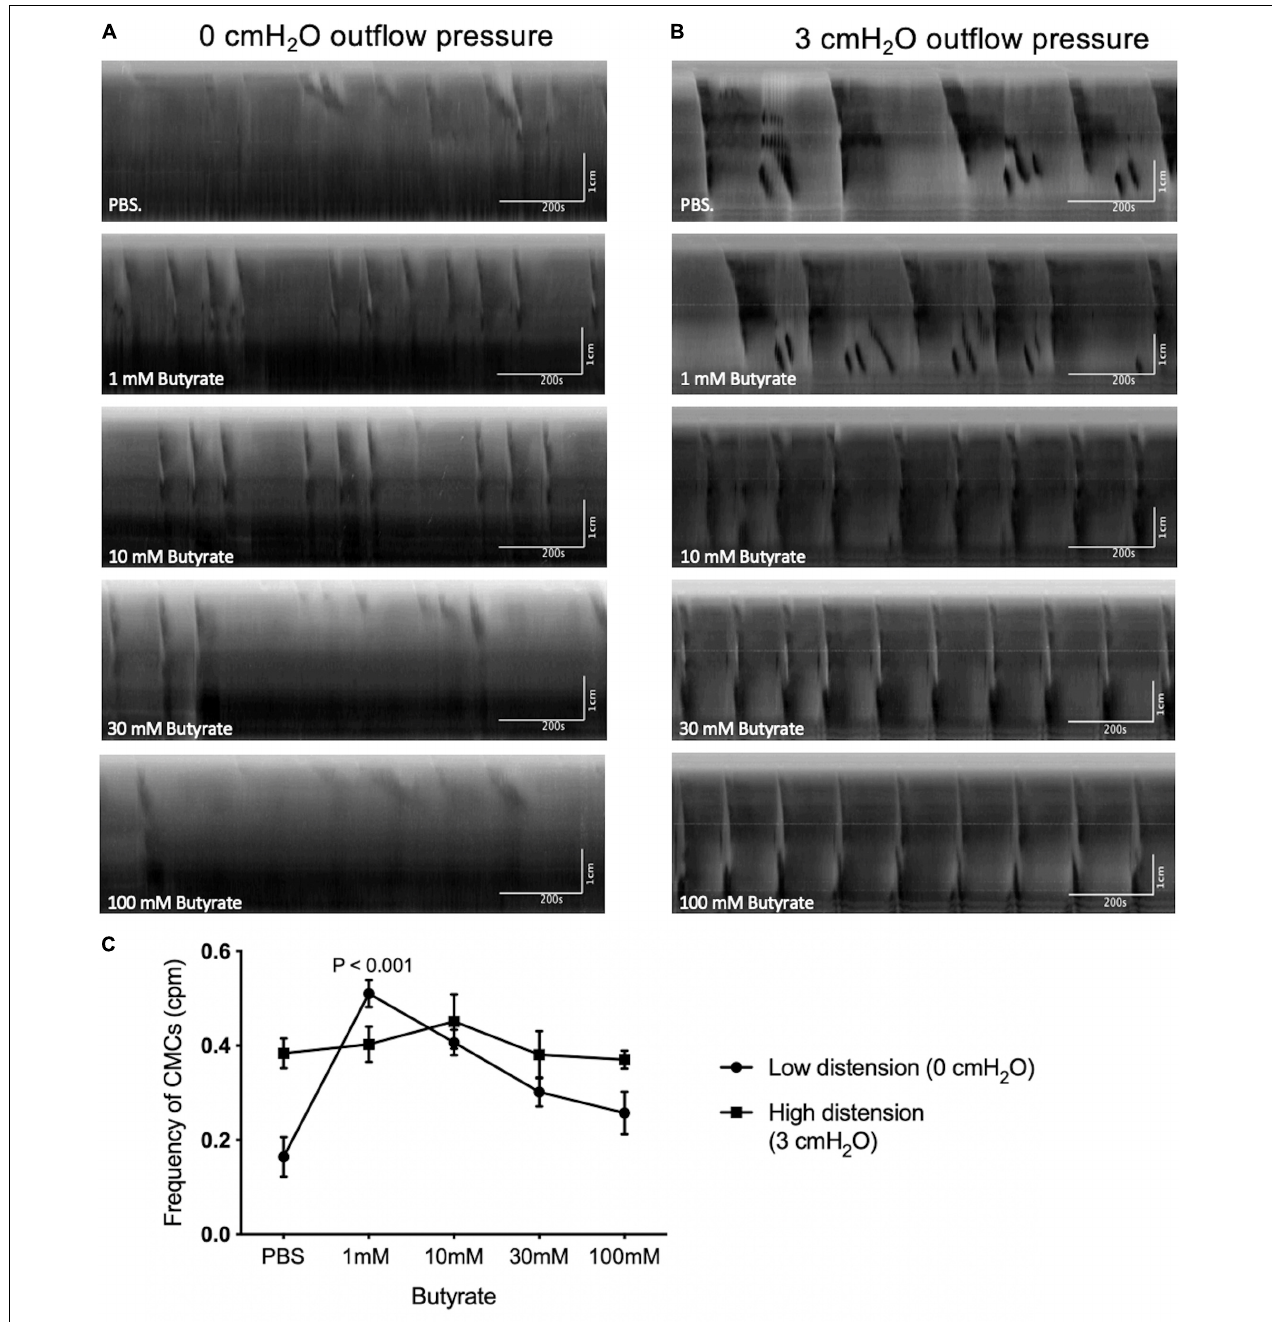
FIGURE 5 | The effect of butyrate at fixed levels of high and low distention on CMCs. (A) Spatiotemporal maps showing the effects of increasing butyrate concentrations on colonic motor activity under low distention. Administering 1 mM of luminal butyrate caused proximal rhythmic contractions to extend into pan-colonic CMCs, specifically FPCs. LDCs were formed at 10 mM of butyrate but disappeared upon continued increases in butyrate concentration to 30 mM or 100 mM. (B) Spatiotemporal maps showing the effects of increasing butyrate concentrations on colonic motor activity under high distention. Administering 10 mM of butyrate increased CMC frequency on average. Further increases in CMC frequencies were inconsistent in response to 30–100 mM butyrate. (C) Frequency of CMCs in response to varying concentrations of butyrate in high and low distention. Butyrate (1 mM) significantly increases CMC frequency in instances of low intraluminal pressure and activity, as simulated by low distention (0 cmH 2 O of outflow pressure) ( N = 10, P < 0.001). Increasing the concentration of butyrate to 10 mM, 30 mM or 100 mM did not further augment CMC frequency. Butyrate has a negligible effect on CMC frequency in instances of high intraluminal pressure and baseline motor activity, as simulated by high distention (3 cmH 2 O outflow pressure) ( N = 7). P values were determined by a one-way ANOVA and Tukey’s post hoc test.